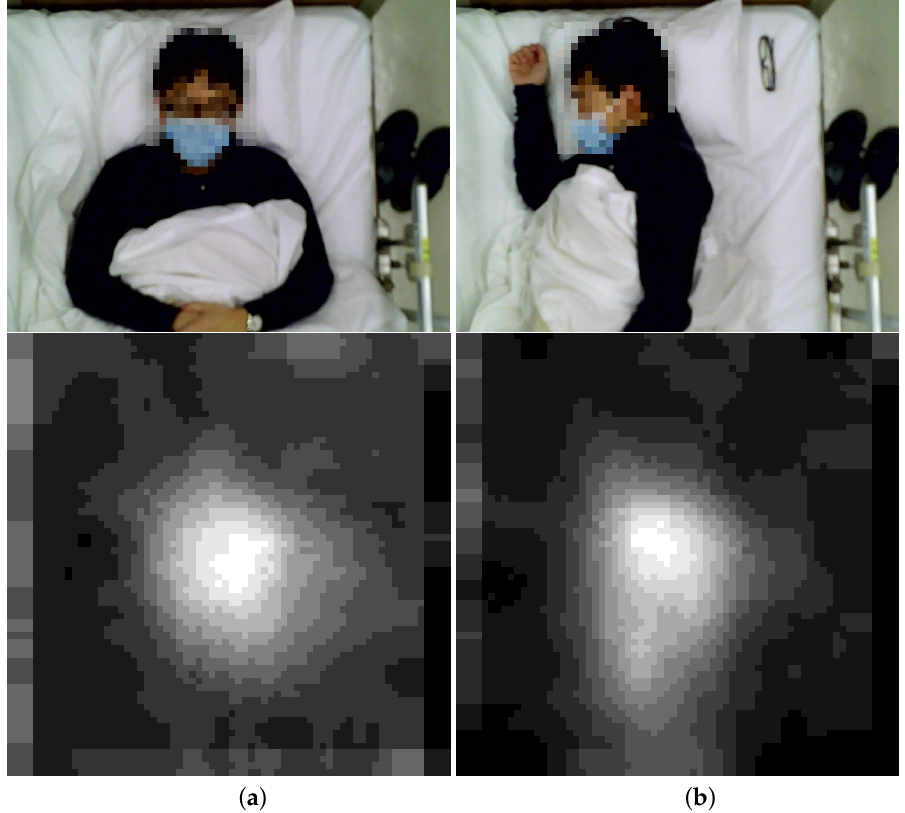
Figure 1. Color Photos and Thermal Images at Okayama Hospital, Japan: ( a ) Laydown, ( b ) Turn to the